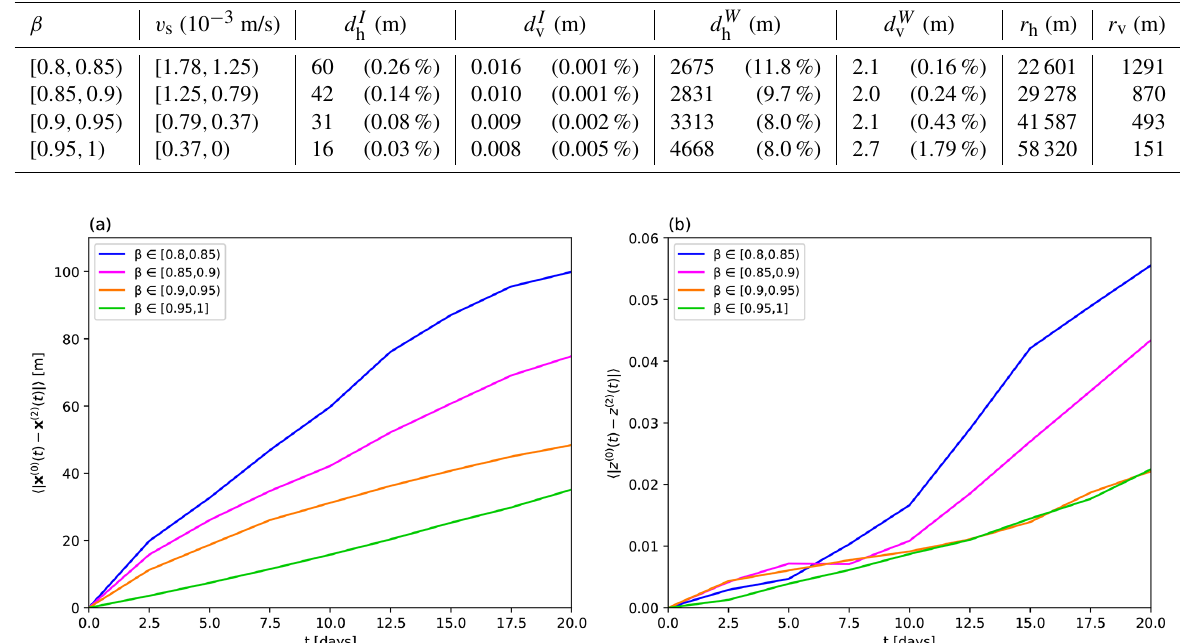
Figure B3. Average horizontal distance d I (a) and average vertical distance d I v (b) of particles released from the same initial location but h integrated with Eqs. (1) and (B1) in the NEMO velocity field. The different lines are obtained from particles from different ranges of densities characterized by the indicated ranges in β .